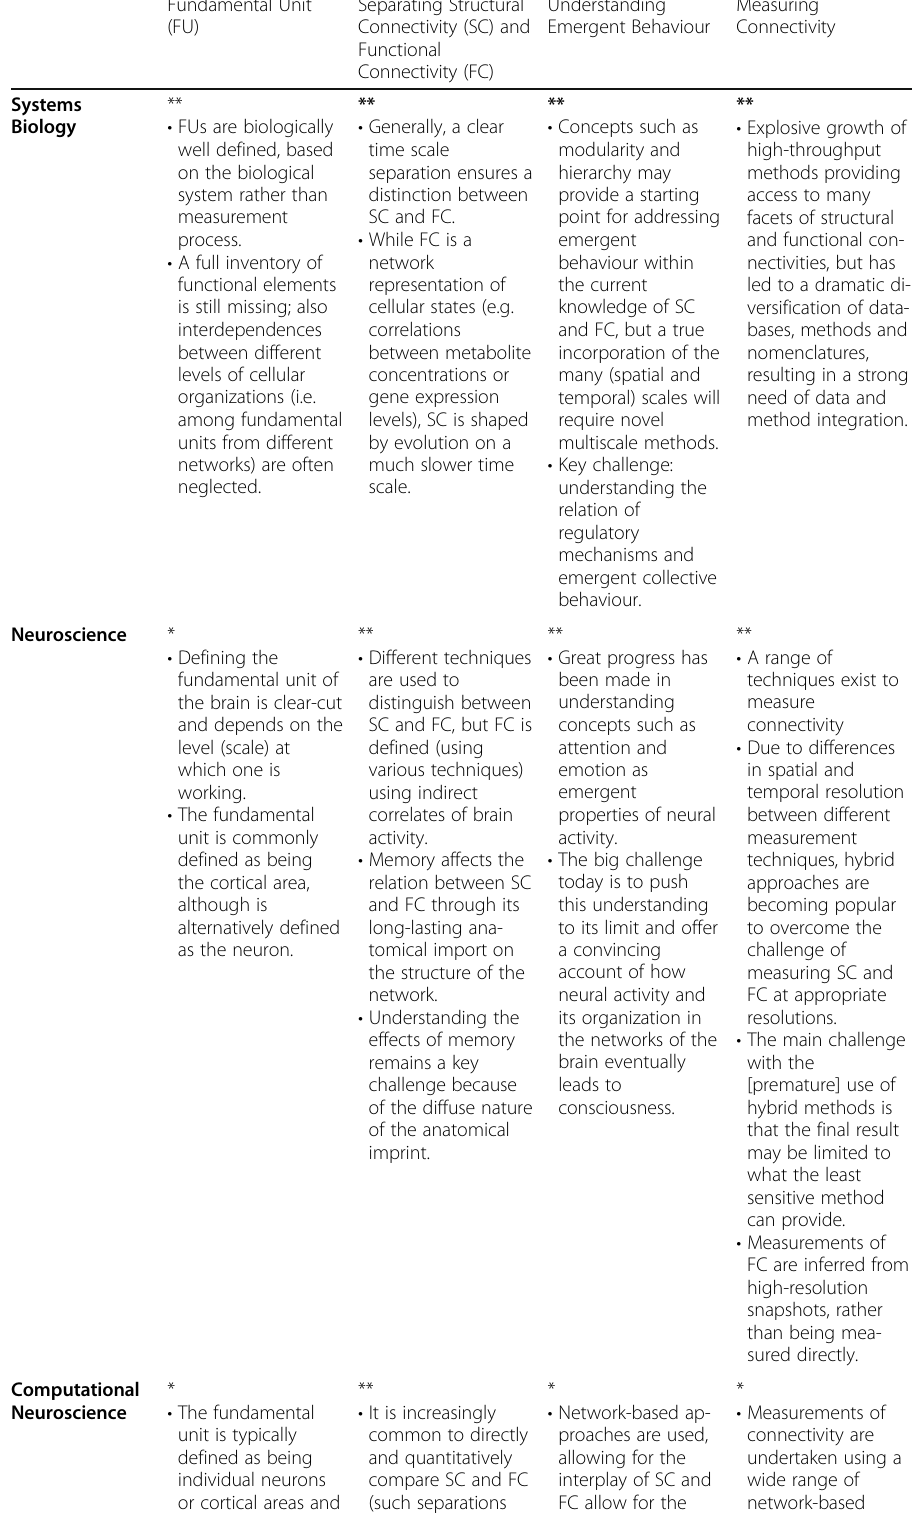
Table 1 Summary of connectivity challenges across different disciplines. Extent to which connectivity challenges are an issue: * do not present a challenge; ** presents a challenge but progress has been made; *** presents a major